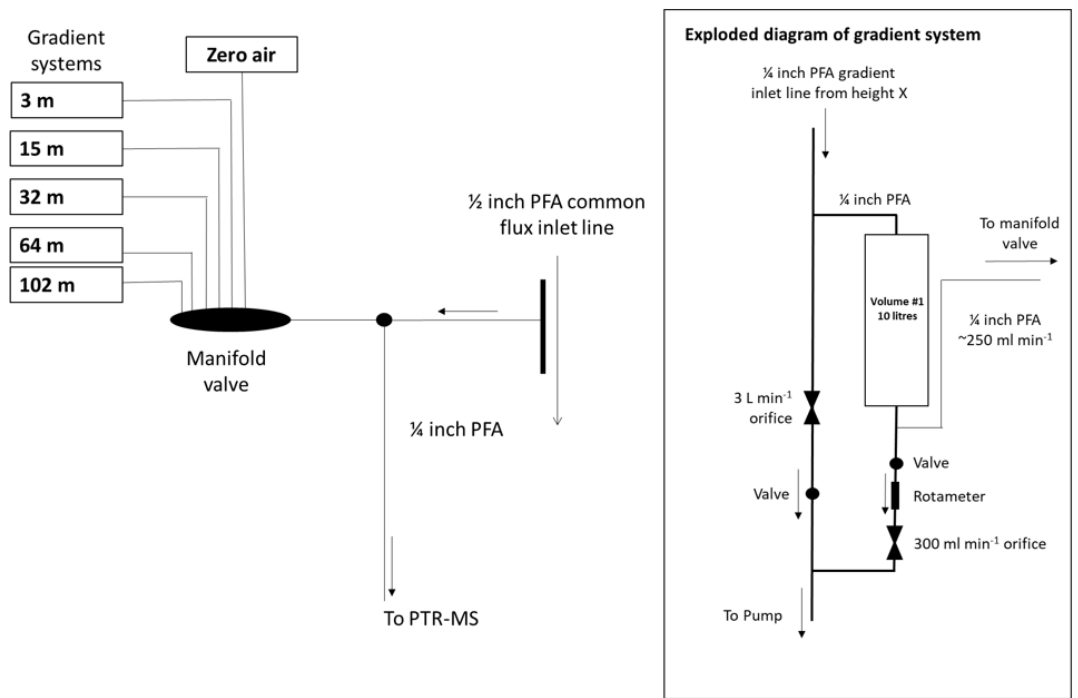
Figure 1. Schematic of the gradient sampling system. The PTR-ToF-MS inlet was switched between a common flux inlet line (40min) and a gradient switching manifold (20min) in an hourly cycle. The gradient system sampled from five heights into 10 stainless steel